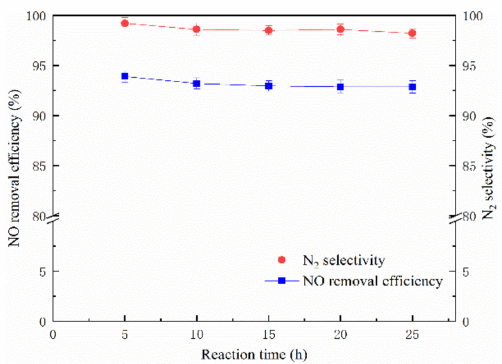
Figure 11. The catalytic long-term stability of the 10% Mn-8% Cu / ZSM5